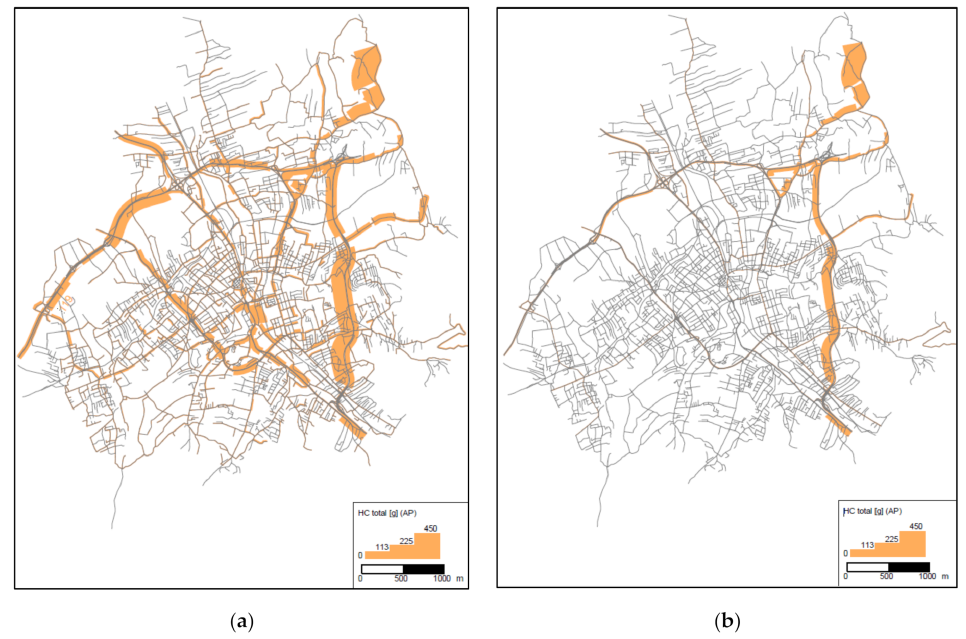
Figure 7. The assessment of HC total [g] (measure from Group 1) for scenario W0 and optimal scenario (W4)—analysis for the whole city: ( a ) measure for scenario W0; ( b ) measure for scenario